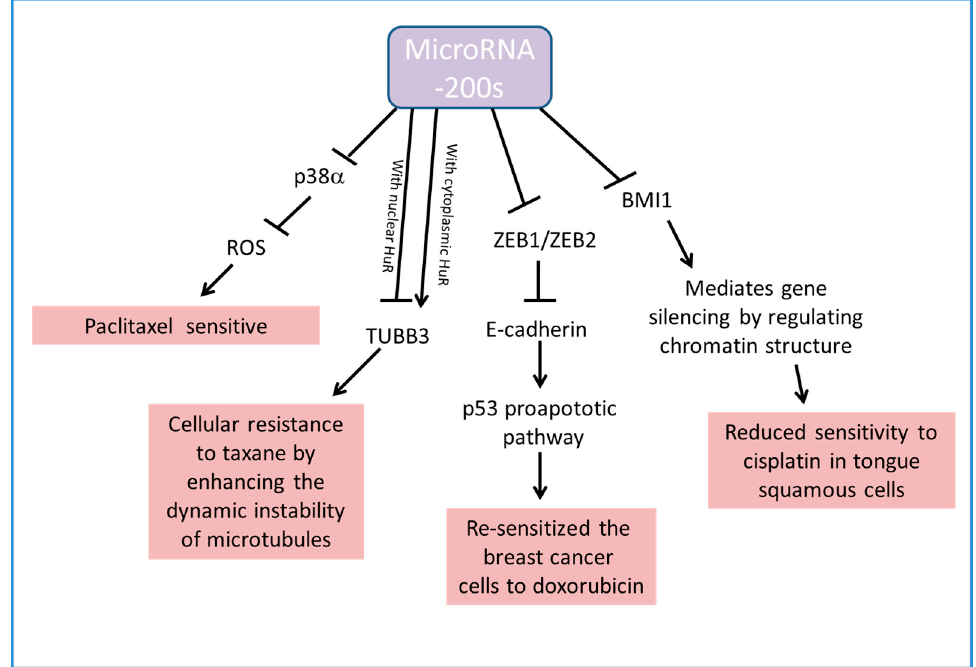
Figure 3. Schematic diagram showing that miR-200s regulate chemoresponse in cancer cells through p38 α , TUBB3, E-cadherin and BMI1. TUBB3: Class III β -tubulin gene, ZEB1/2: zinc finger E-box-binding homeobox 1/2, BMI1: polycomb group RING finger protein 4.